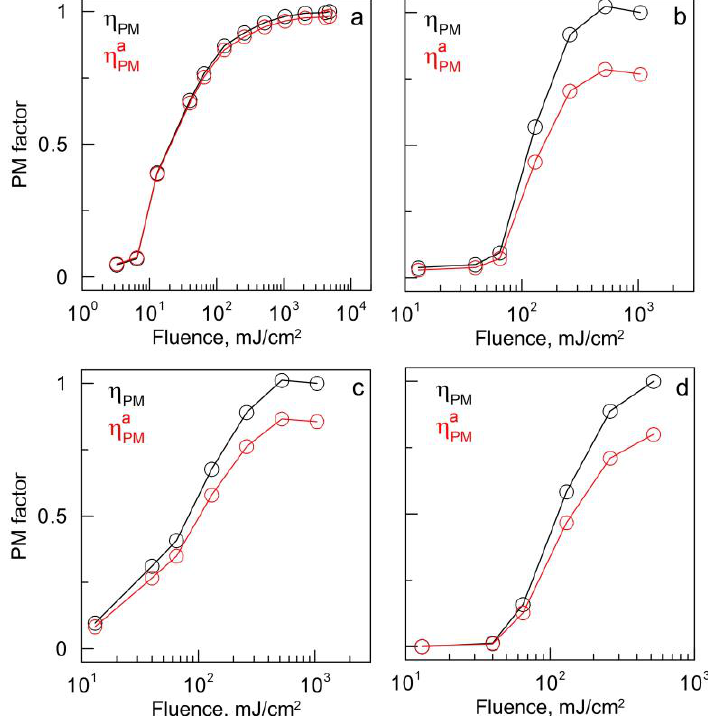
Figure 10. PM factor η PM (black curve) and approximate PM factor η a P M of fluence for four types of gold nanoparticles: nanorods ( a ), nanostars ( b ), nanoantennas ( c ), and nanoshells on silica cores ( d ).